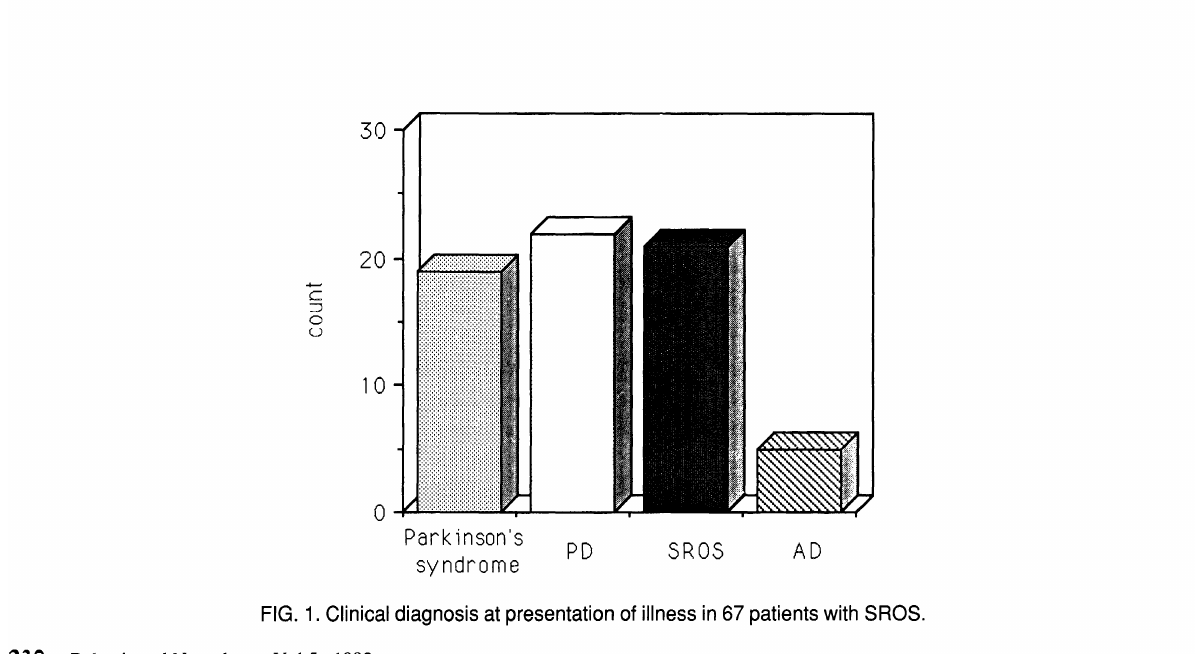
FIG. 1. Clinical diagnosis at presentation of illness in 67 patients with